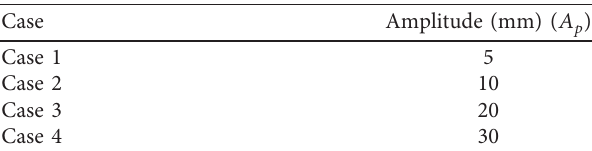
Table 6: Different cases for the MR damper experiment.